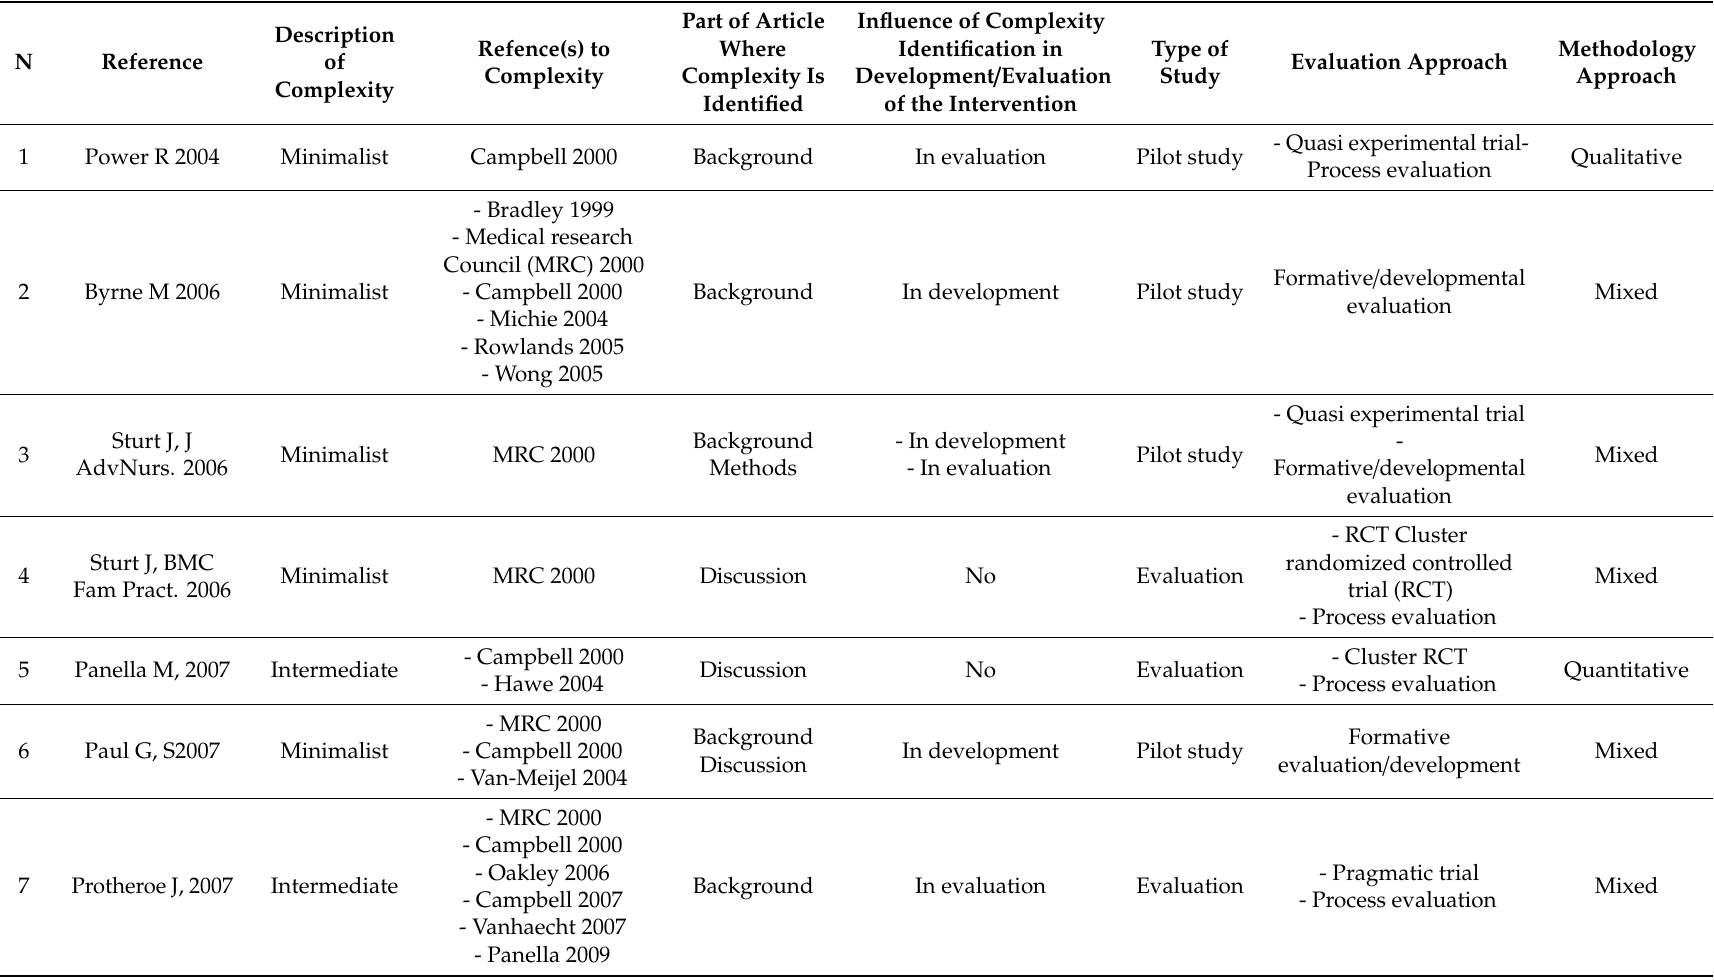
Table 2. Description of included